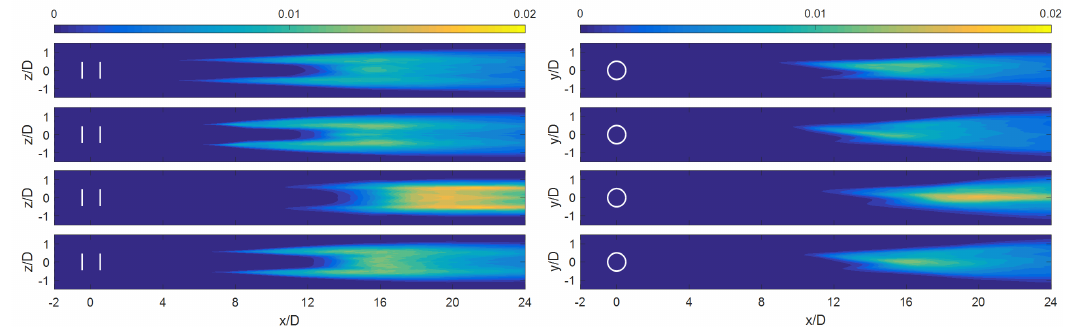
Figure 7. Contours of the normalized subgrid-scale (SGS) dissipation rate ( (cid:101) sgs D / U 3 vertical x − z plane ( left ) and in the central horizontal x − y plane ( right ) for different SGS models: (from top to the bottom) LSDD model, AMD model, SMAG model with C S = 0.16, and SMAG model with C S = 0.065.